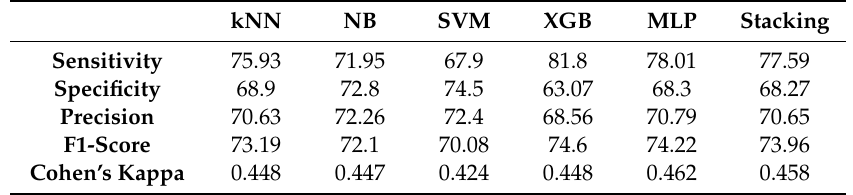
Table 12. Models Performance (Sensitivity, Specificity, Precision, F1-score, Cohen’s Kappa).